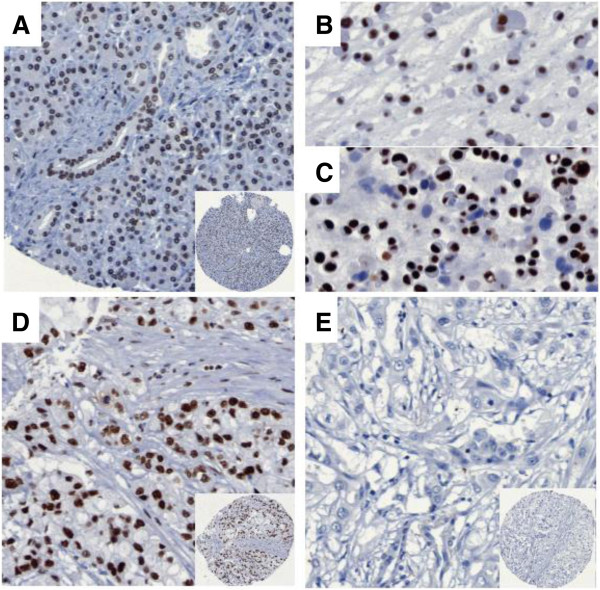
Immunohistochemical staining of STAG2 in pancreatic cancer. Near ubiquitous staining in (A) ductal cells of normal tissue, (B) the primary cancer cell line PaCaDD161, and (D) pancreatic cancer. (C) The cell line PaCaDD135 displays a heterogeneous staining pattern, whereas in (E) a minor fraction of pancreatic cancer STAG2 expression is lost. Magnification 200× (insets 100×).